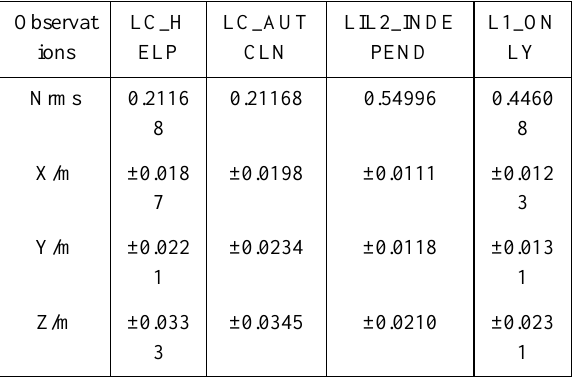
Table 3. Observations on the accuracy of the baseline vector